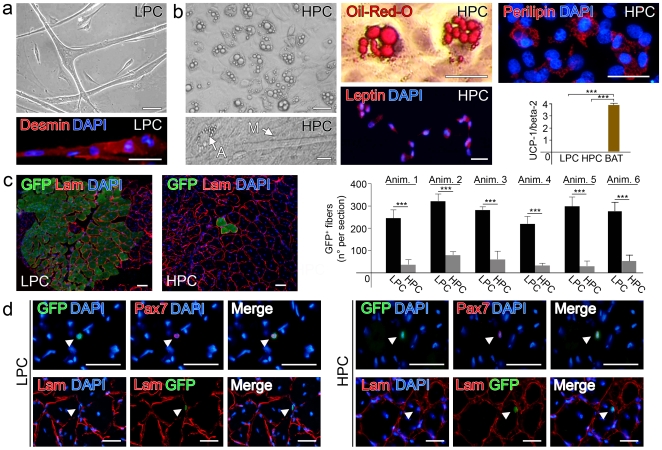

In vitro and in vivo differentiation potential of subpopulations of SCs.(a) Spontaneous differentiation potential of LPC and HPC in high serum medium: LPC give rise to mature myotubes (top), as visible through phase contrast microscopy, that were positively immunostained for desmin (bottom, bar = 100 µm). (b) HPC give spontaneously rise to adipocytes, well visible through phase contrast microscopy (top left), and a small amount of myotubes (bottom left). Lipid droplets are marked through Oil-Red-O staining (top center) and immunostaining for perilipin (top right) (bar = 100 µm). Immunostaining for leptin on HPC (bottom center). Real-time PCR for mitochondrial uncoupler protein UCP-1 on LPC and HPC, compared with brown adipose tissue (BAT) (***p<0.001; bottom right). (c) Epifluorescence analysis for GFP and immunostaining for laminin on muscle sections injected with LPC (left) and HPC (center). On the right is reported a diagram indicating for each of six animals treated the amount of GFP+ fibers per section of muscle injected with LPC and HPC (mean±s.d.,***p<0.001). (d) Immunofluorescence analysis for Pax7 and epifluorescence for GFP, merged with DAPI on sections of muscles treated with LPC (top panel, left) and HPC (top panel, right). Epifluorescence for GFP and immunostaining for laminin, merged with DAPI, on sections of muscles treated with LPC (lower panel left) and HPC (lower panel right) (bar = 100 µm).